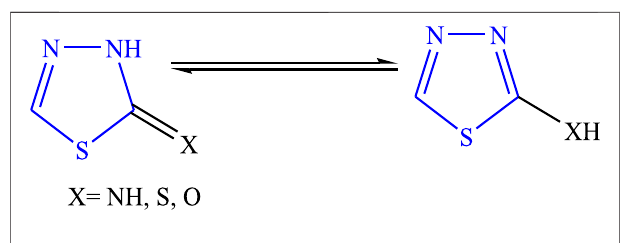
FIGURE 2 | Tautomeric behavior of 1,3,4-thiadiazole.